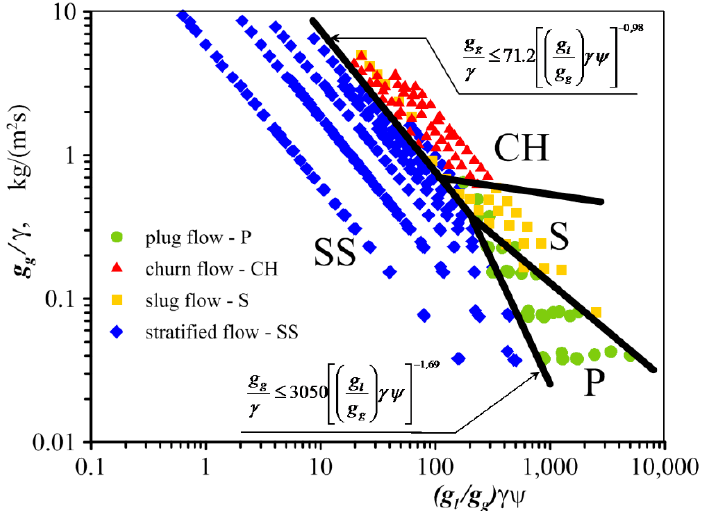
Figure 16. Map of the gas–liquid flow through horizontal channels filled with metal foams, developed by Dyga and Placzek [48].